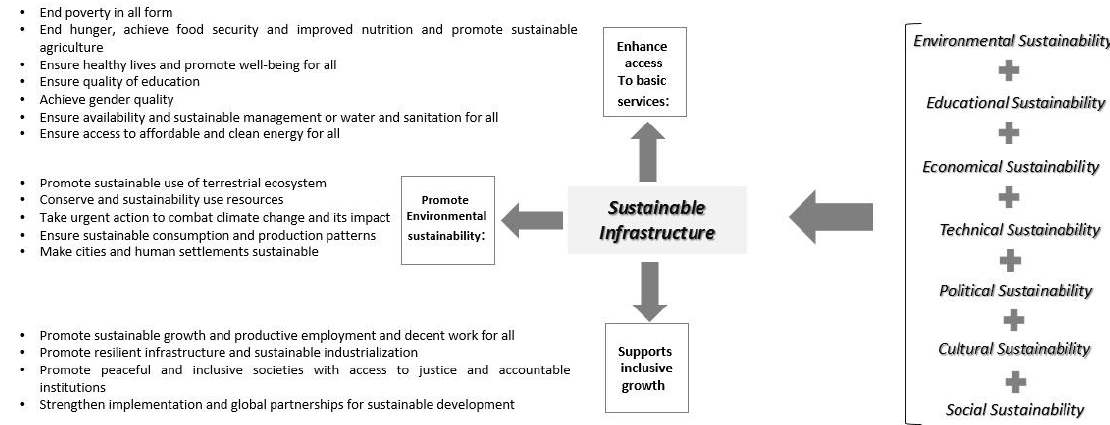
Figure 8. Sustainable infrastructure.